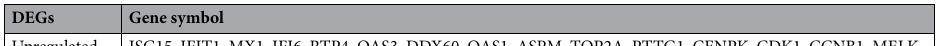
Table 2. 15 central genes were selected by STRING and Cytoscape software from PPI network.